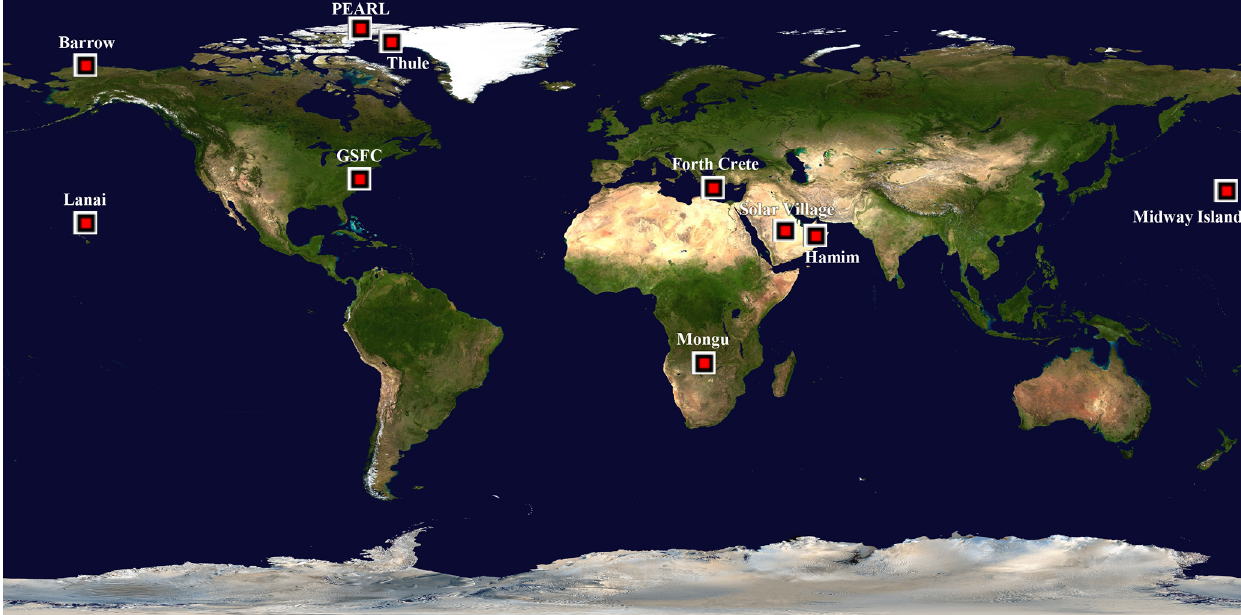
Figure 4. AERONET stations employed for generating the statistics employed in this paper. These stations were chosen to represent a regional variety of aerosols (pollution, biomass burning, dust mixtures, sea-salt mixtures and Arctic aerosols). See Table 1 for